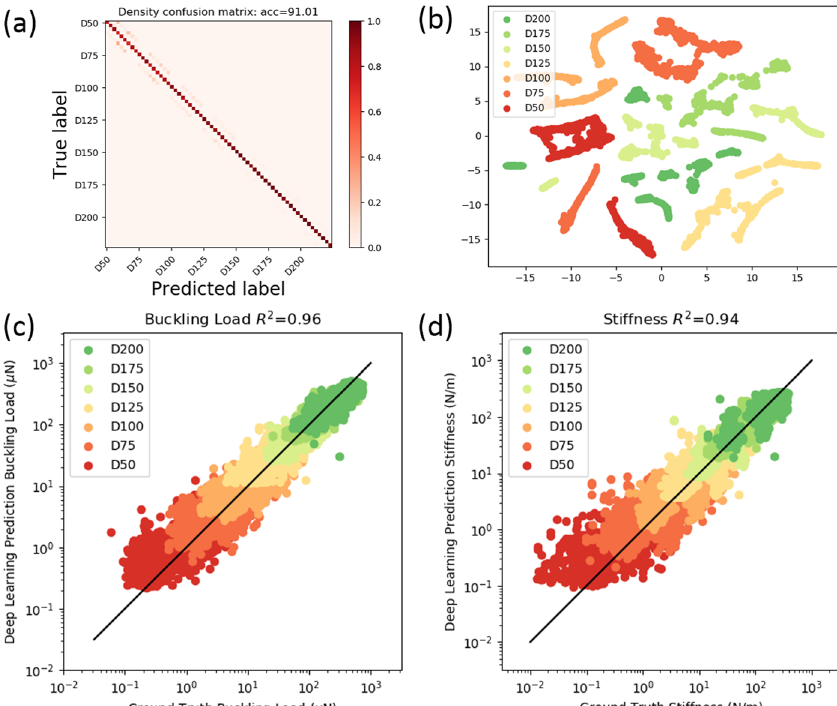
Fig. 6 CNTNet classi fi cation and regression accuracy. a Confusion matrix for 63 CNT classes with the ordering based on seven CNT densities and nine sub-types. b t-SNE visualization of the 63 CNT forest classes grouped by the seven CNT population densities for better visualization. The separation of the density groups using the VGG-19 feature embedding sub-space indicates that the CNT forest density is classi fi ed with high accuracy. CNTNet regression prediction for ( c ) buckling load and ( d ) stiffness compared to the simulated ground-truth values. Data are colored according to the CNT forest linear